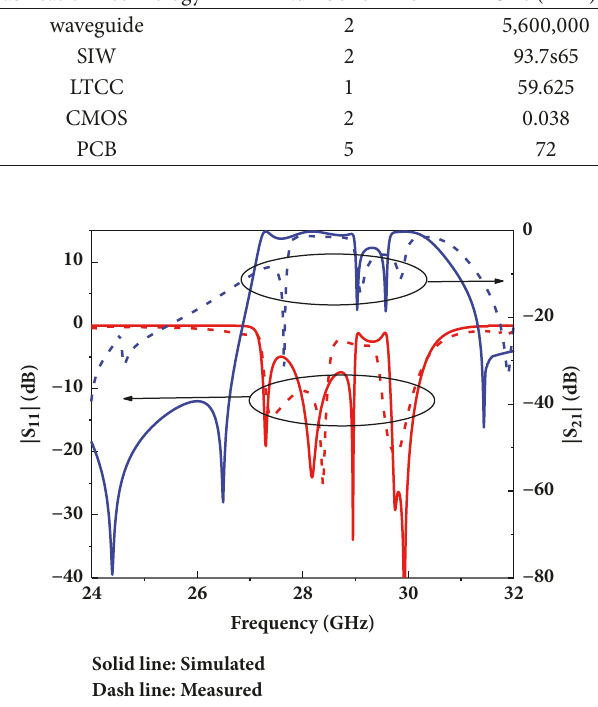
Figure 8: Simulated and measured results of the proposed dual- band BPF (solid line: simulated results; dash line: measured